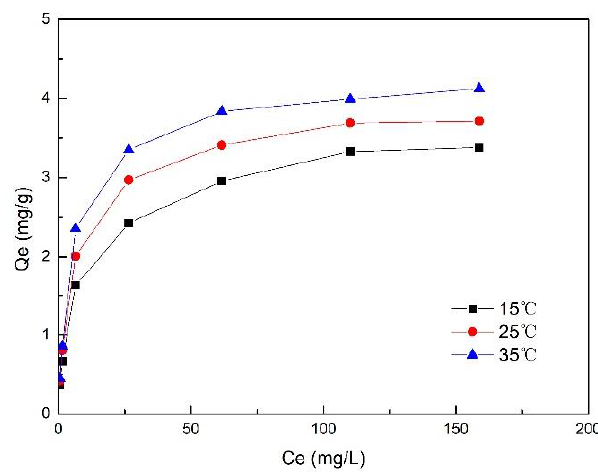
Figure 2. Adsorption isotherm of ZSFB composite fiber.